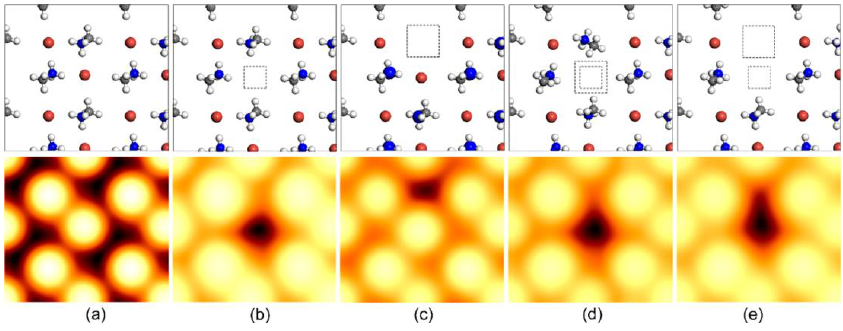
Figure 10. Simulated STM images of ( a ) the pristine CH 3 NH 3 PbBr 3 (010) surface and ( b ) the surface with a Br vacancy V Br ; ( c ) a MA vacancy V MA ; ( d ) a Br-Pb double vacancy V Br-Pb ; and ( e ) a Br-MA double vacancy V Br-MA . All these STM images were calculated with a W(111) tip model. The squares show the position of missing Br, Pb atoms or MA cations. V bias = −3.0 V. Color code: N (blue), C (gray), H (white), Br (brown). The figure was taken from Reference [60] with permission. After the discussion of surface defects existing in perovskite crystal, which affects the stability of perovskite, the surface morphology of perovskite crystals exposed in ambient conditions will be discussed. The aged surfaces (from as-grown single crystals) of CH 3 NH 3 PbBr 3 are shown in Figure